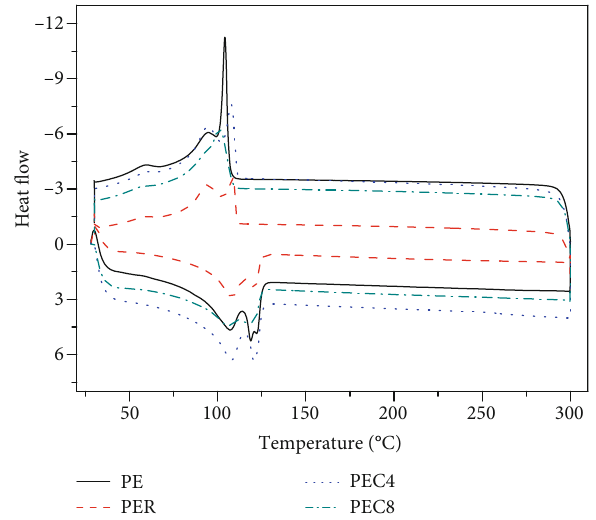
Figure 1: DSC study of PE and its recycled composites.